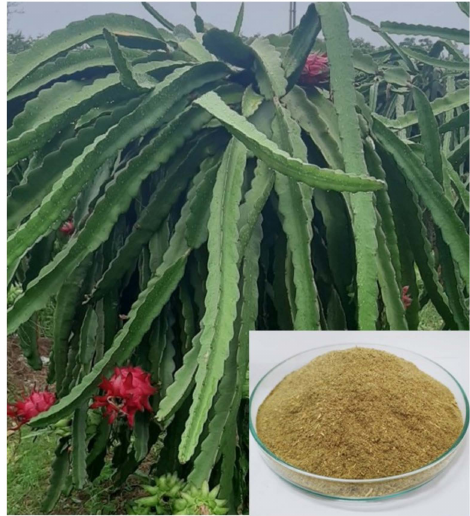
Figure 1. Dragon Fruit foliage (DFF) during the harvest season in Hai Duong, Vietnam. Collected DFF were air dried and mechanically milled into fine particles, as shown in the